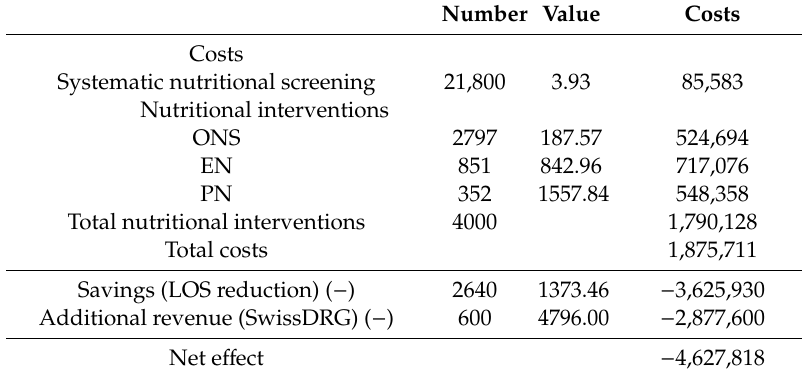
Table 4. Costs resulting from a systematic